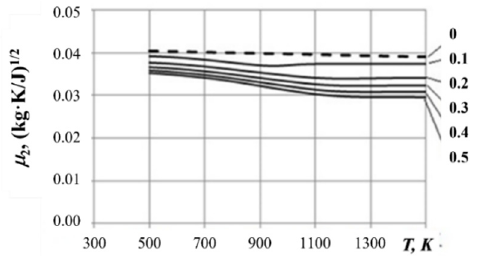
Figure 7. Coefficient µ 2 for calculating gas mass flow rate at GG outlet depending on the PP-to-air mass ratio at 1 MPa.